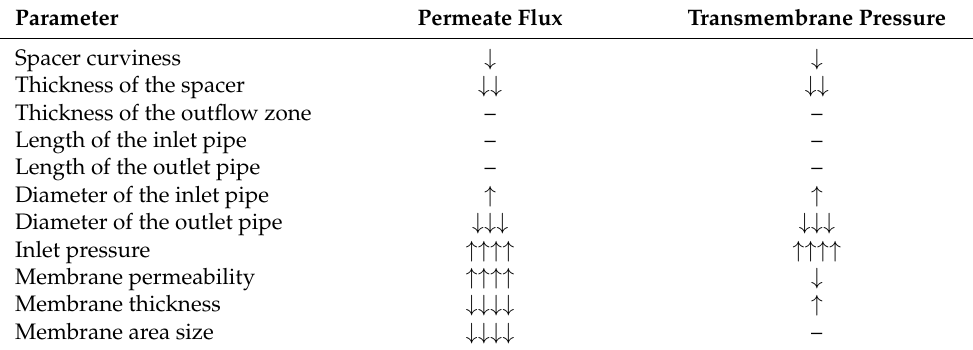
Table 3. Qualitative overview of several sensitivity analysis parameters on the permeate flux and the transmembrane